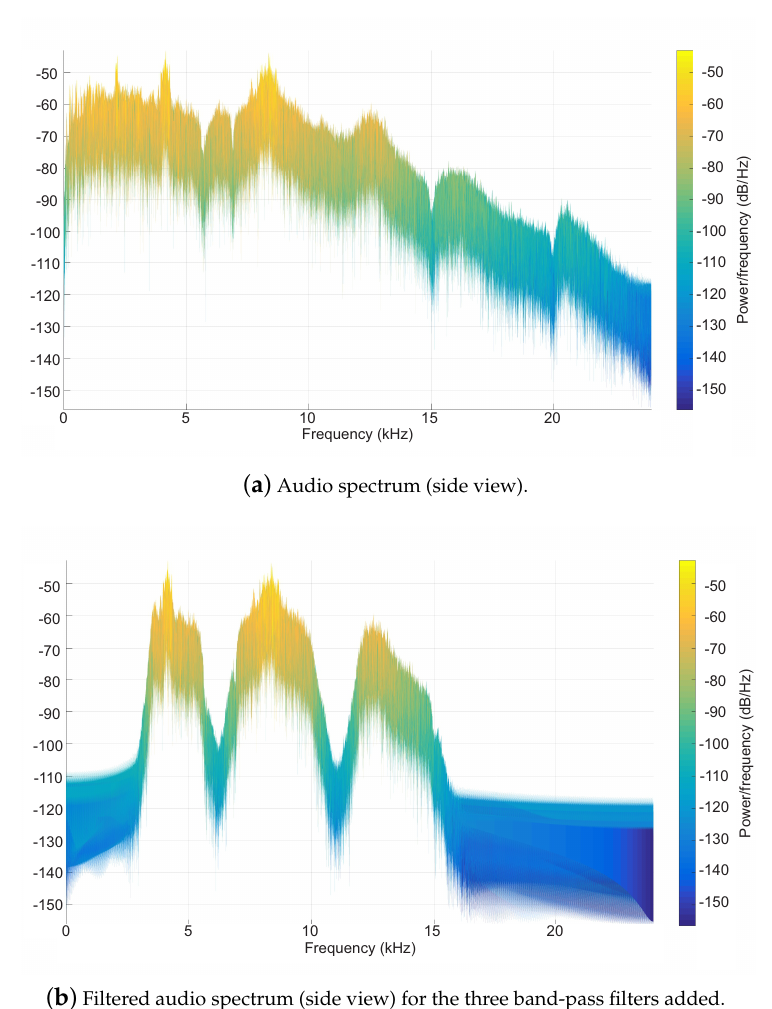
Figure 7. A set division with the band-pass filter.